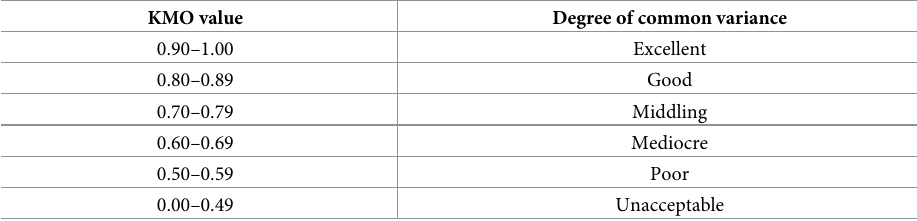
Table 5. Acceptance level of the KMO value.